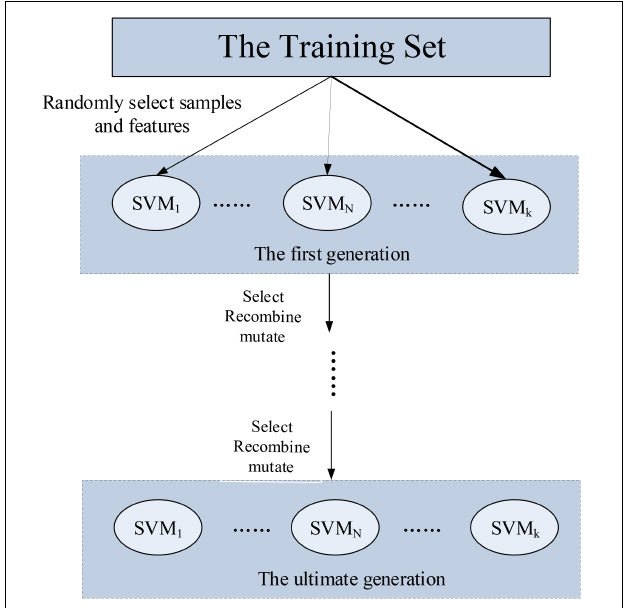
FIGURE 1 | The design of the genetic-evolutionary random SVM cluster.